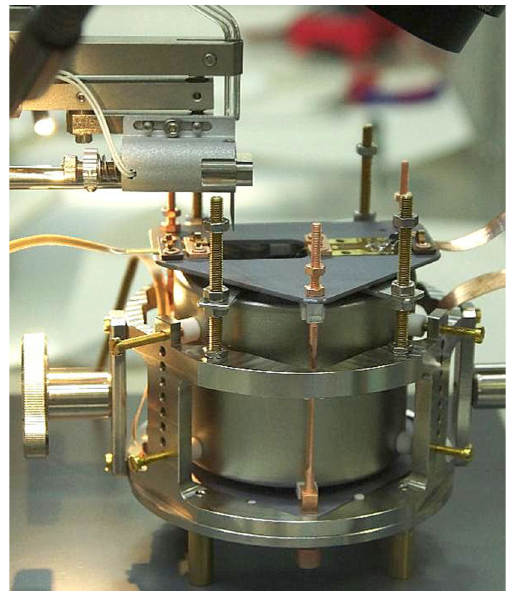
Fig. 4 A detector module with two BEGe detectors within its jig. The top plate of the jig has been removed to provide full access for the deep-access bonder